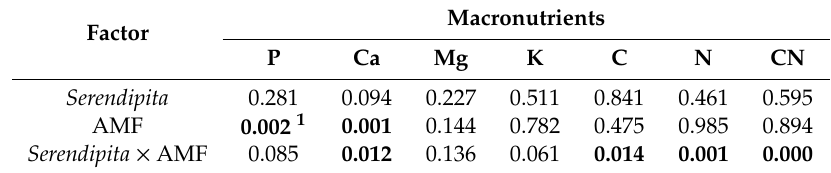
Table 4. Results of the two-way ANOVA ( p -values) for macronutrient concentrations in tomato shoots nine weeks after transplanting with the factors ‘ Serendipita ’, ‘AMF’, and ‘ Serendipita × AMF’ interaction ( p < 0.05, n = 4). Macronutrients Factor P Ca